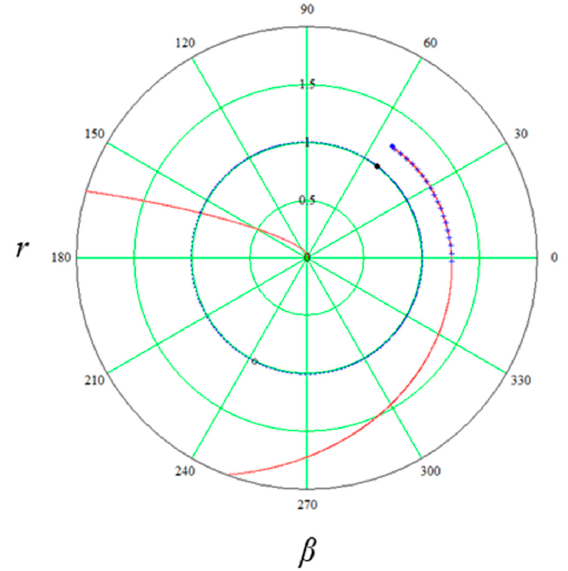
Figure 15. Section of the flight trajectory with a negative value of selenocentric energy. Shown with blue crosses; it can be seen that the energy becomes negative at a fairly significant distance from the moon.